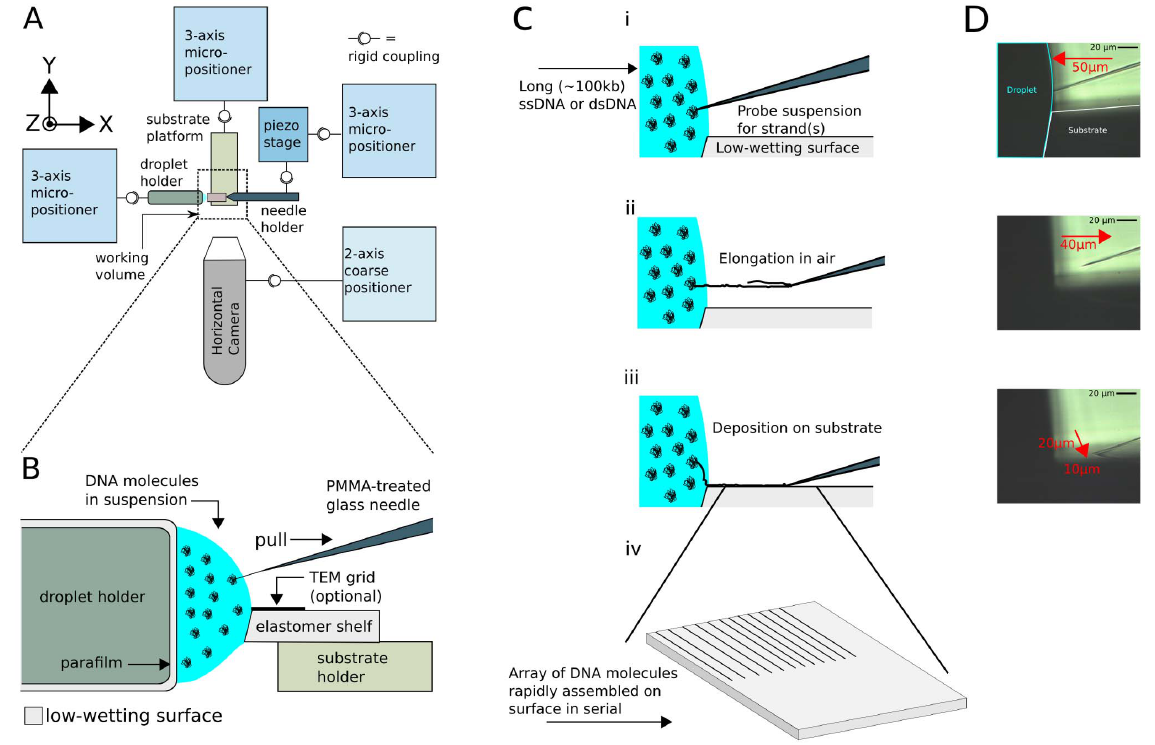
Figure 1. Molecular threading apparatus. ( A ) Device for stretching and positioning DNA molecules extracted at a liquid-air interface. A set of three 3-axis micro-positioners are used for coarse alignment of a DNA-binding tip, a target substrate, and the droplet containing a DNA suspension. Horizontal and vertical cameras are used to monitor the process (vertical camera not shown). ( B ) Illustration of the work area for ‘‘spider’’ threading. The droplet is immobilized between two low-wetting surfaces and a piezo-controlled tip is then moved between the surface of the suspension and the adjacent substrate. ( C ) Molecular threading at a liquid-air interface. ( i ) Needle tip penetrates into DNA suspension, binding to one or more strands (collectively called a ‘‘thread’’). ( ii ) Needle tip extracts from the suspension parallel to substrate surface. The restoring force of the meniscus places the bound thread in tension. ( iii ) Needle tip is brought into direct contact with the target surface, transferring the strand to the substrate and the needle. ( iv ) A lateral translation of the needle after each extraction permits the creation of an array of linearized DNA. ( D ) Images of the needle, droplet, and substrate, taken under magnification, and corresponding to the illustrations in (C).